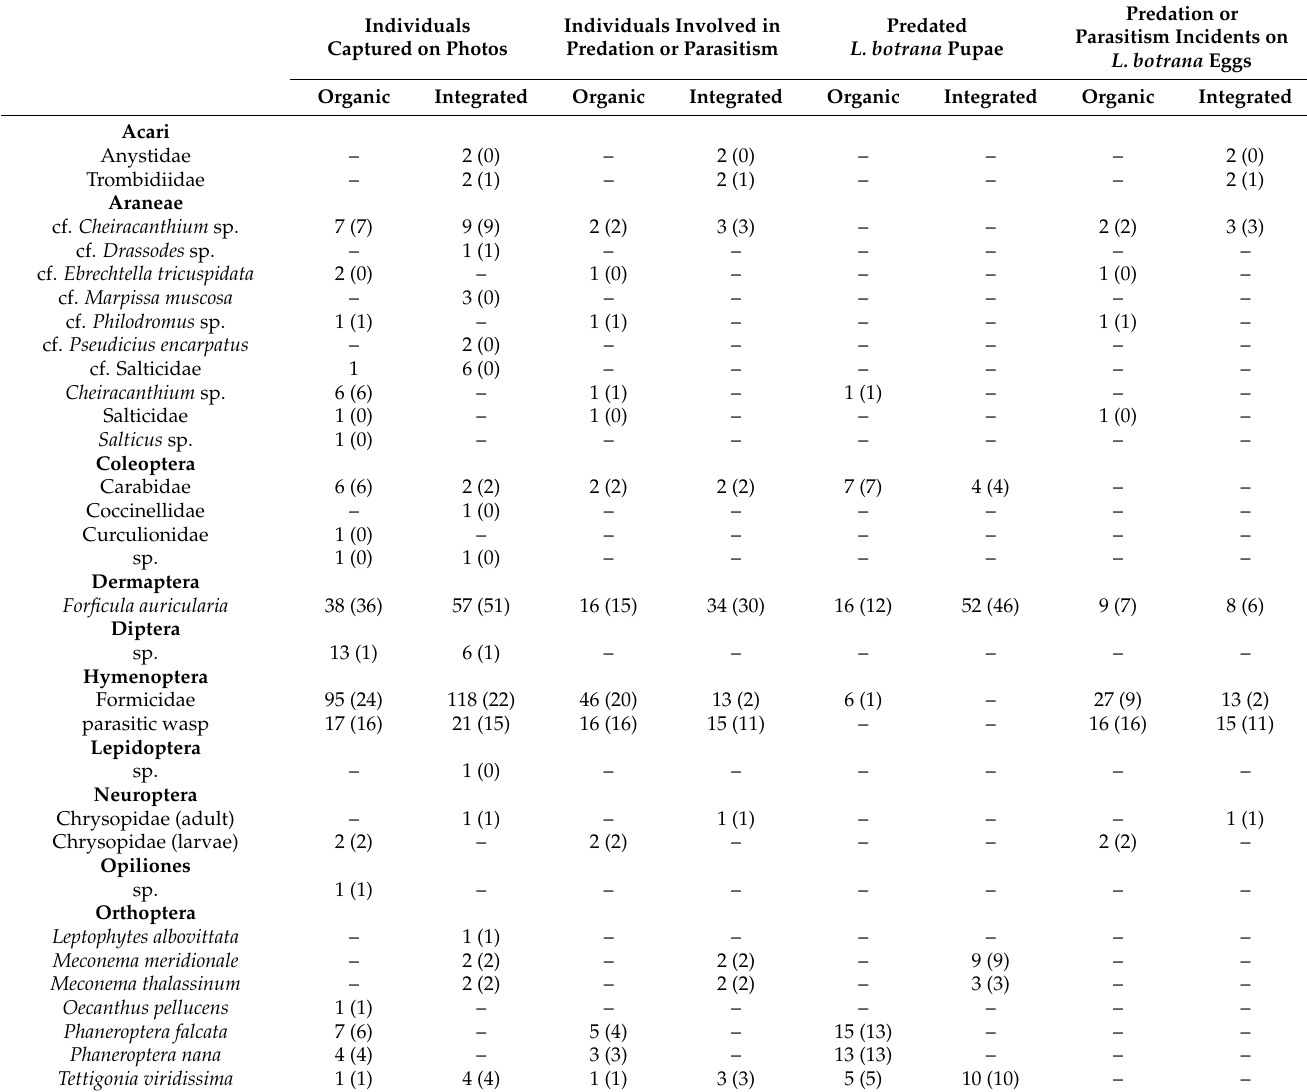
Table 4. Number of predator occurrences and pest control potential of camera-surveilled L. botrana sentinel cards in one selected vineyard pair. Nocturnal events are in